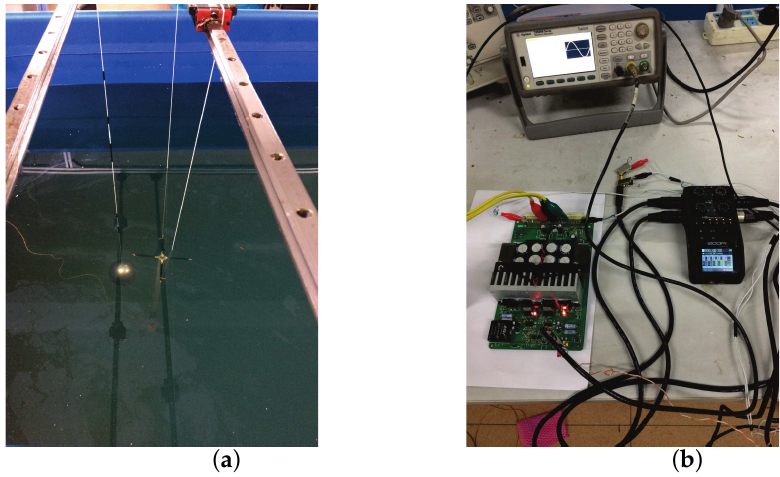
Figure 14. ( a ) The image of the experiment environment; ( b ) the amplifier of the electro-locator and the ZOOM H6 Handy Recorder.